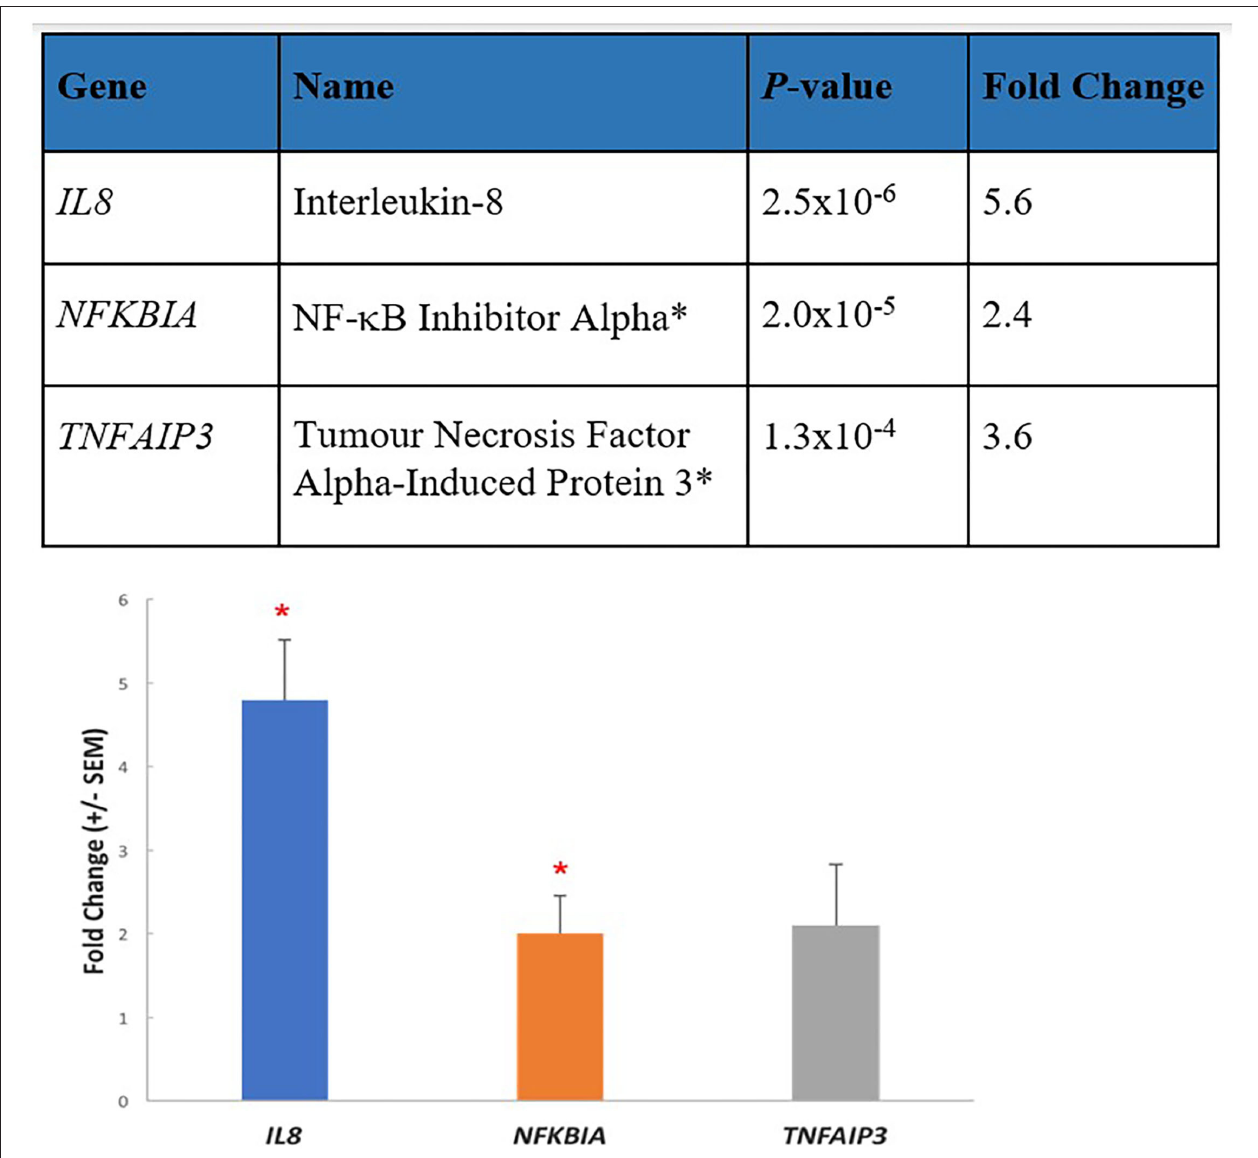
FIGURE 2 | Three key elevated transcripts in immune cells from ME/CFS patients are involved in inflammation. The most enhanced transcripts from RNA-seq data ( p -value 0.01/fold change 1.5) in PBMCs from 10 ME/CFS patients compared with 10 age/gender matched healthy controls shown in the upper part of the figure were Interleukin 8 (IL8) a proinflammatory cytokine, and two inhibitory transcripts, NF- κ B inhibitor alpha ( NIFKBIA ), and tumor necrosis factor alpha-induced protein 3 ( TNFAIP3 ). These were validated by determining the mean fold changes by RT-qPCR ( ± SEM) between the patient group and the healthy control group, and similar fold changes were determined. * p <